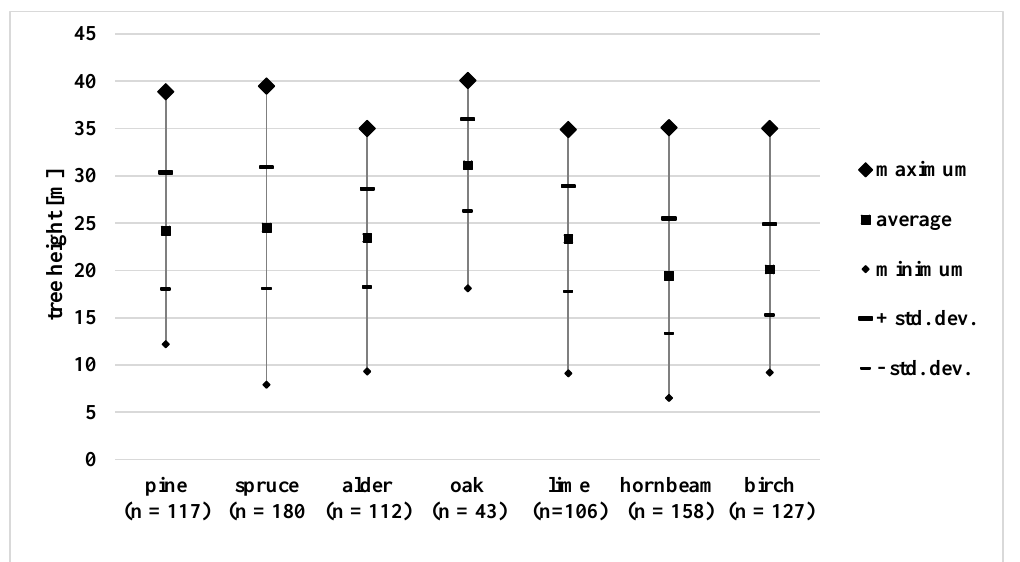
Figure 2. Descriptive statistics of trees measured in the field.